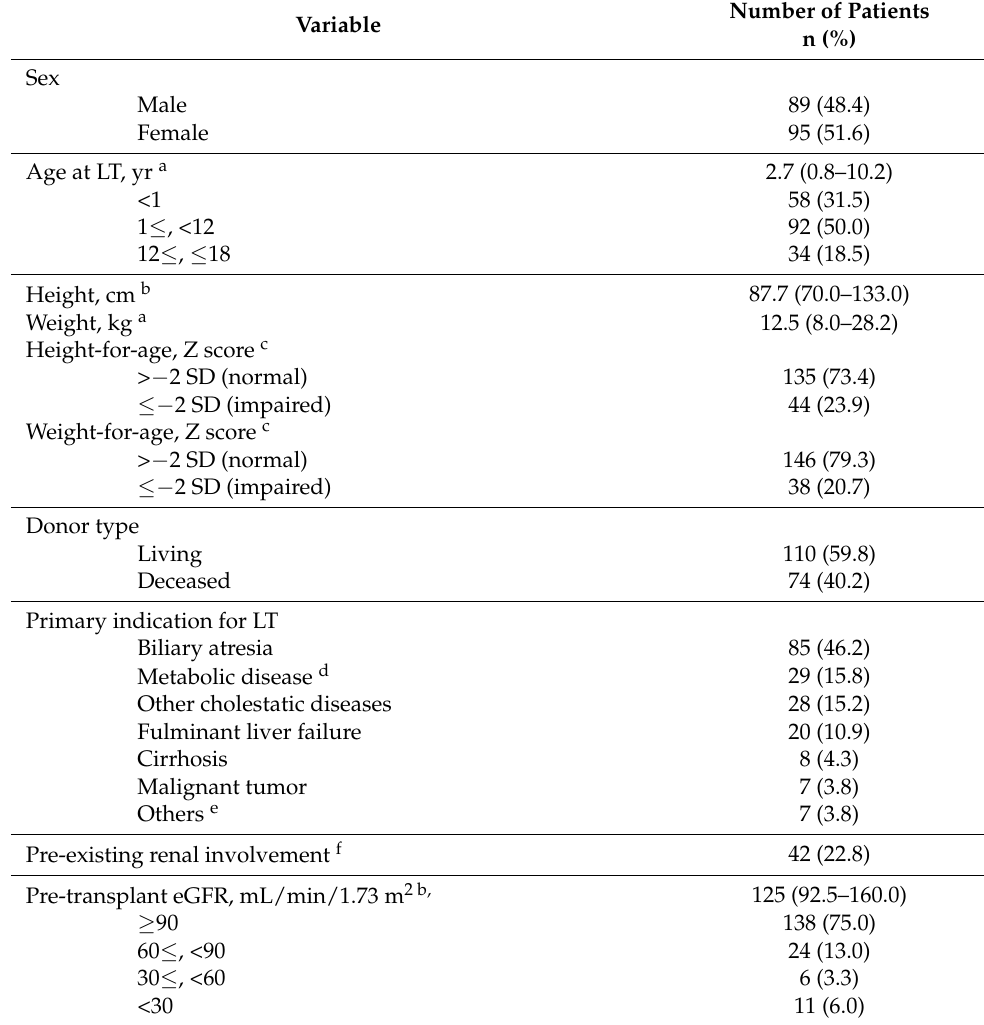
Table 1. Baseline characteristics of study patients (n =